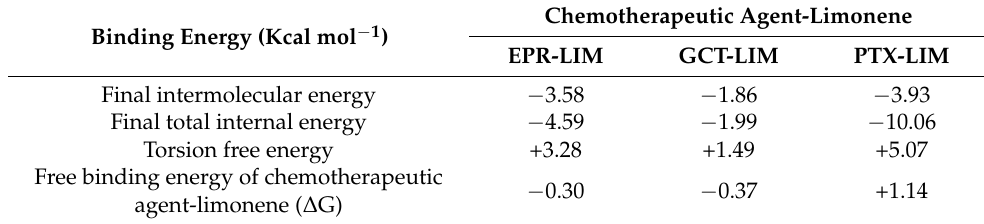
Table 5. Values of chemotherapeutics-limonene binding